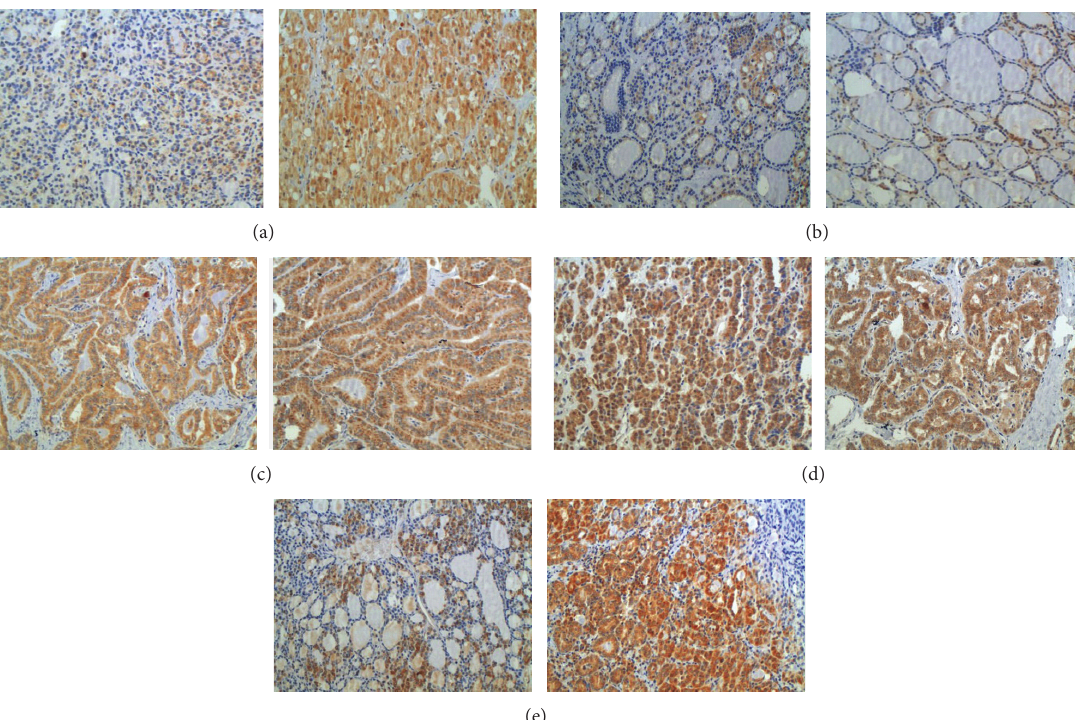
Figure 2: MAGE A3 expression in different lesions, (a) follicular adenoma ( × 200); (b) goiter ( × 200); (c) papillary thyroid carcinoma of the classic form ( × 200); (d) follicular variant of papillary thyroid carcinoma ( × 200), and (e) follicular carcinoma ( ×